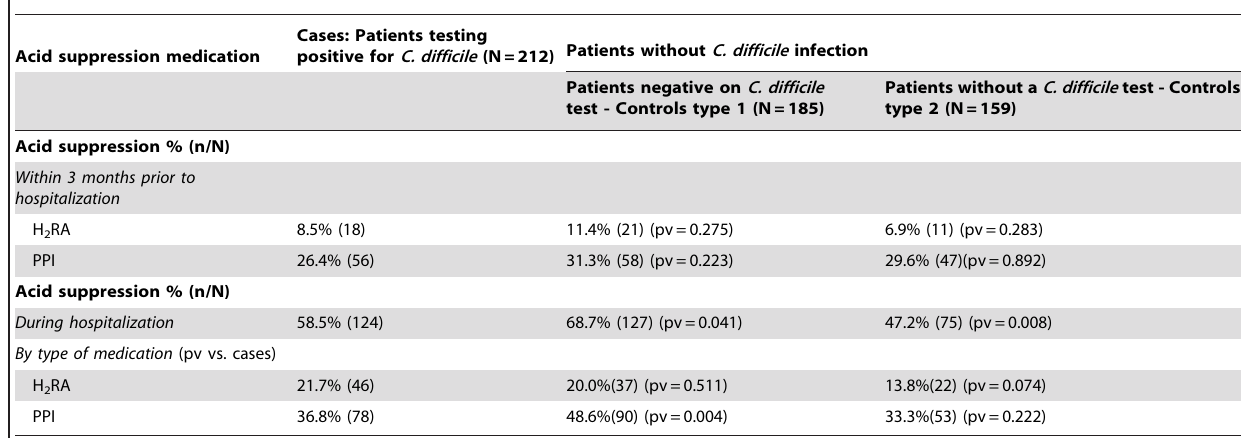
Table 4. Exposure to Acid-suppression medications, by study